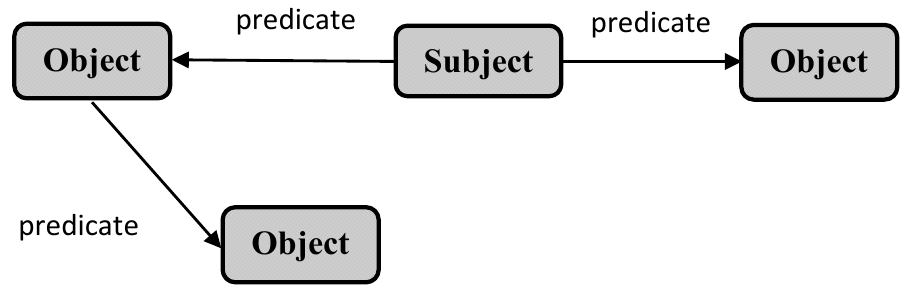
Figure 1. Structure of an RDF graph.